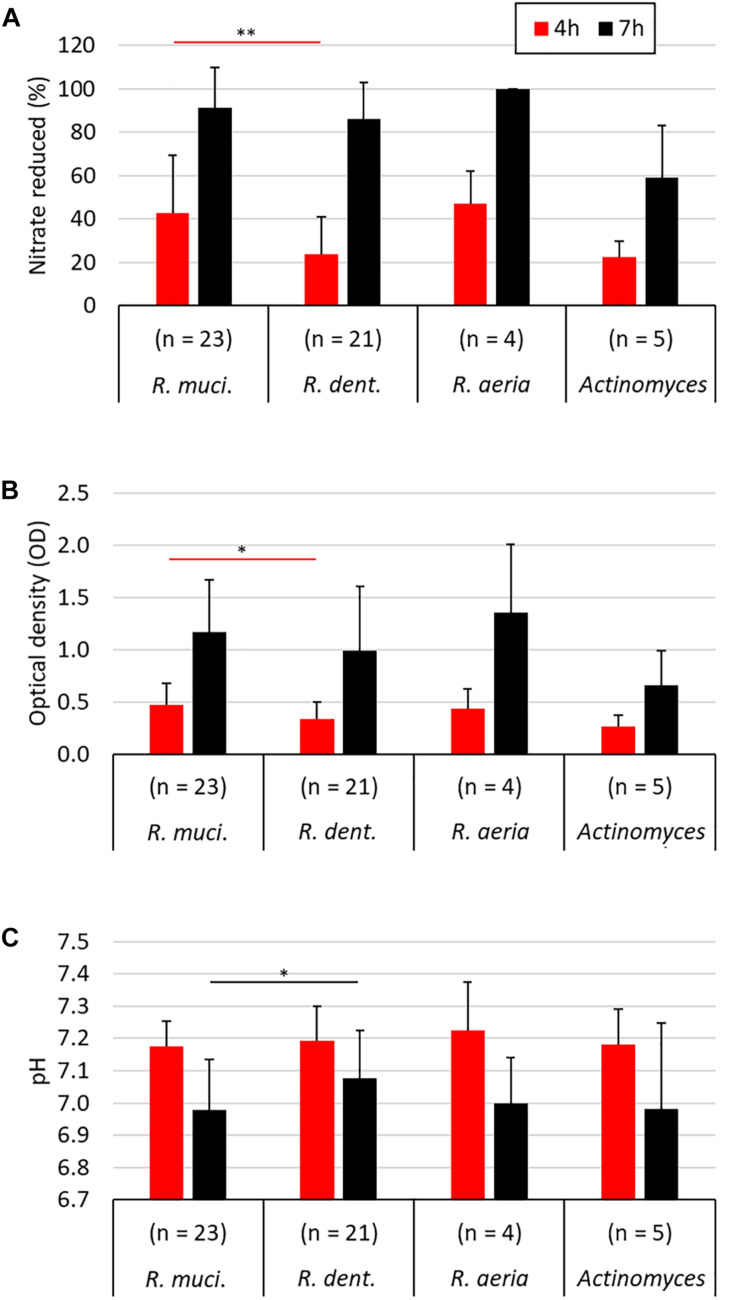
Comparison of different nitrate-reducing species isolated in the current work after 4 and 7 h of growth with 6.5 mM nitrate. The different Rothia species are grouped separately (23 R. mucilaginosa isolates, 21 R. dentocariosa isolates, and 4 R. aeria isolates) and all five Actinomyces isolates are represented together. Bars represent the nitrate reduced (A), optical density (B), and medium pH (C) after 4 and 7 h of growth. Only R. mucilaginosa (R. muci.) and R. dentocariosa (R. dent.), to which most isolates belonged, were statistically compared (Mann–Whitney U test). ∗p < 0.05, ∗∗p < 0.01.